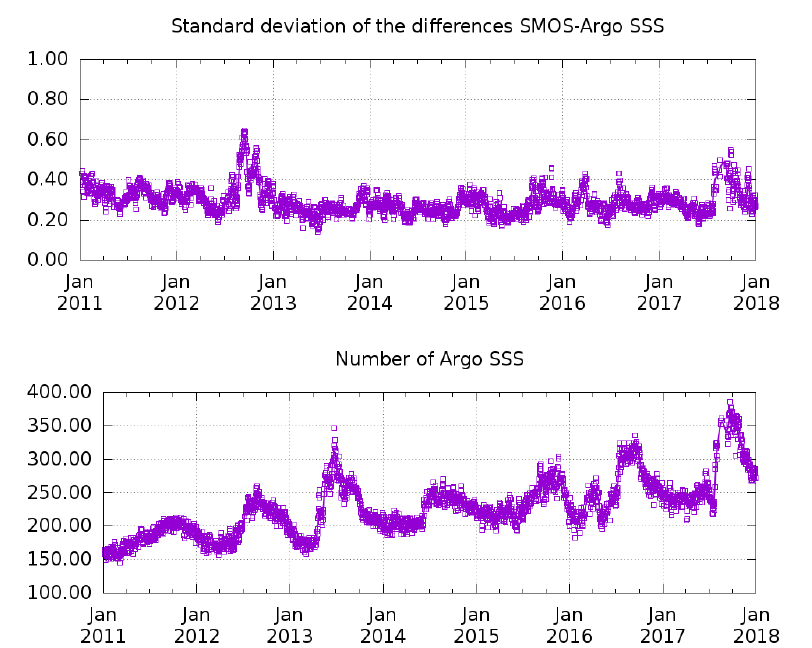
Figure 6. Time evolution of the standard deviation of the differences between SMOS and Argo SSS ( top ); and the number of measurements used in the comparison ( bottom ). The statistics are computed for data above 50 ◦ N. Every SMOS nine-day map is compared with the Argo SSS available for the same nine-day